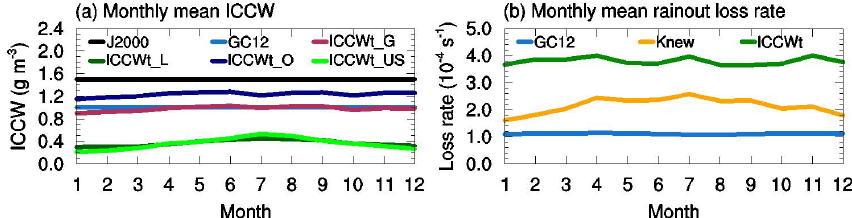
Figure 1. (a) Monthly variations of ICCW averaged over the lower troposphere layers of the whole globe (maroon), global land areas (olive), global oceans (navy), and the continental US (green) from MERRA2, along with constant ICCW values assumed in J2000 (black) and GC12 (blue). (b) Monthly variations of the rainout loss rate averaged in the lower troposphere layers of the continental US based on Eq. (2) (i.e, GC12) and Eq. (3) with constant ICCW of 1gm − 3 , as well as Eq. (3) with MERRA2 ICCW (Eq.